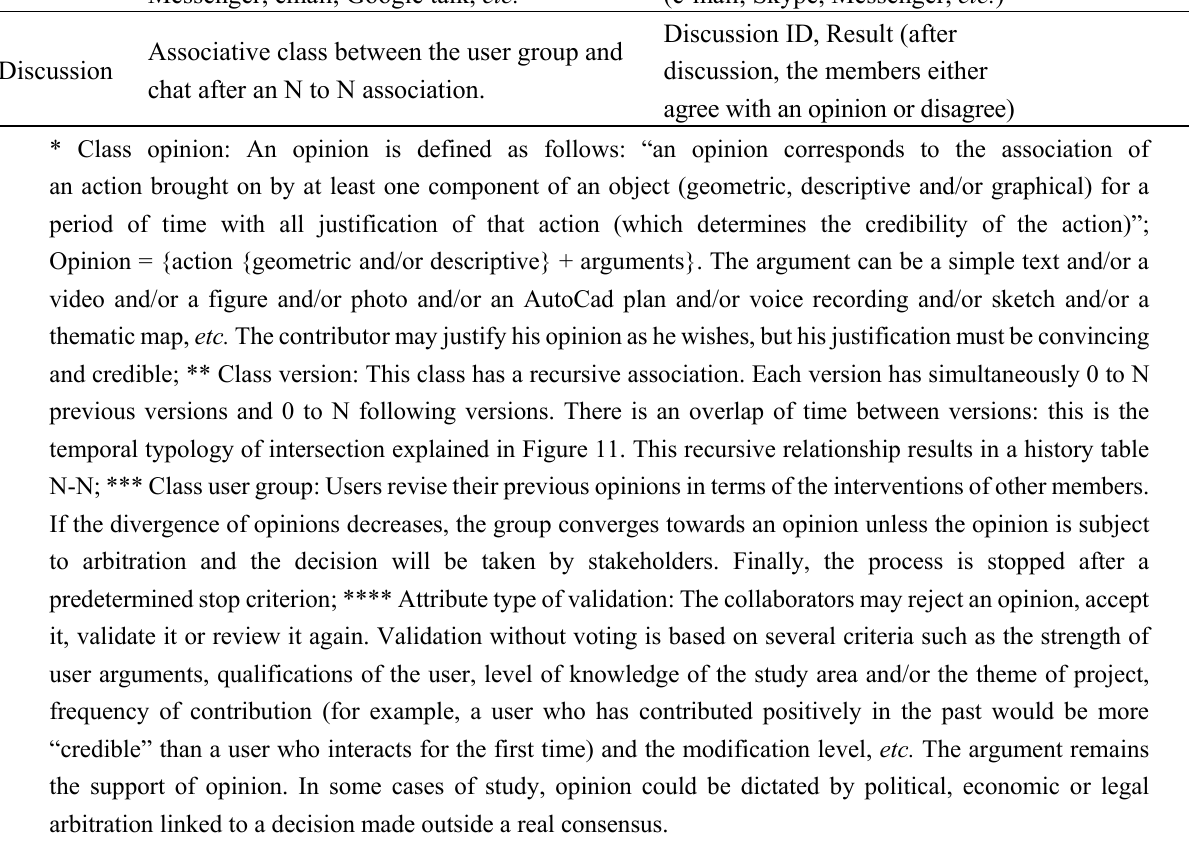
Figure 11 . Temporal typology of intersection between two